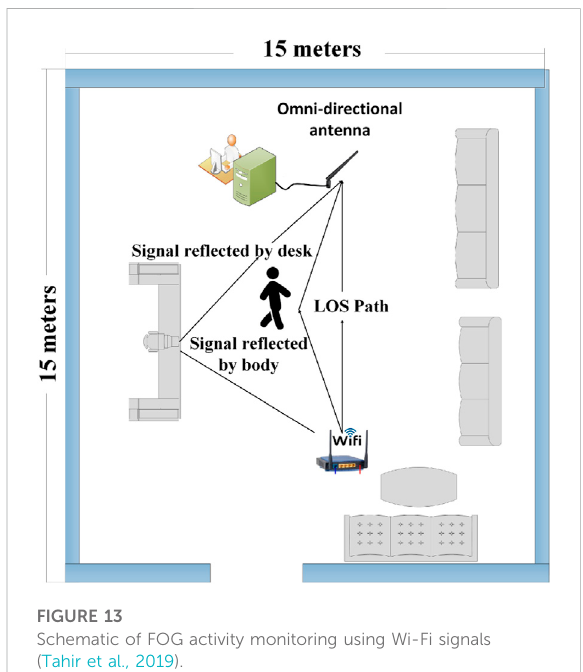
FIGURE 13 Schematic of FOG activity monitoring using Wi-Fi signals (Tahir et al., 2019).